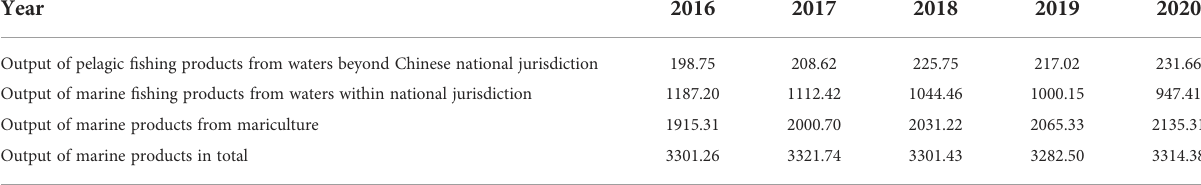
TABLE 2 A survey of the output of marine products in